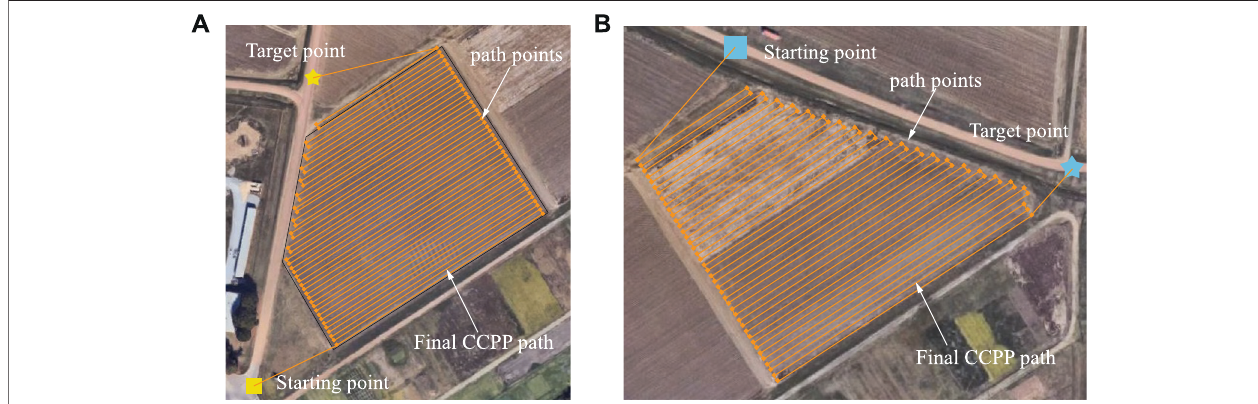
FIGURE10| Illustrationofthe fi naltrajectoryinlightofthedeep learning-based CCPP. (A) The fi naldeep learning-based CCPP pathregardingthetargeted areain Figure 9B . (B) The fi nal deep learning-based CCPP path regarding the targeted area in Figure 9C .